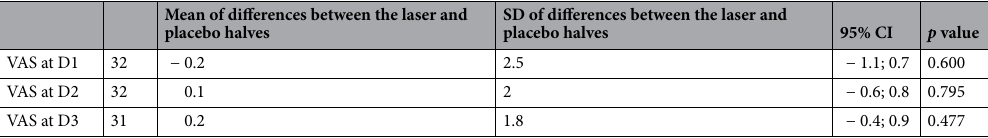
Mean of differences between the laser and placebo halves